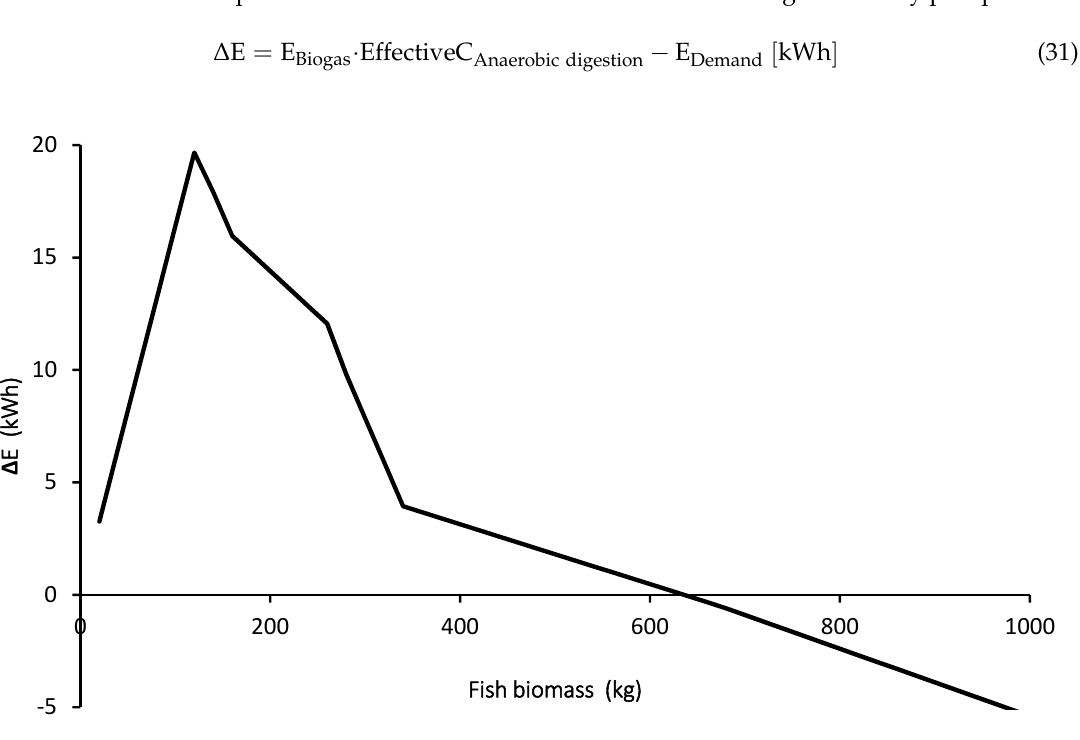
Figure 5. The effect of fish biomass on the differences between the aquaponic system energy demand and production ( ∆ E). Negative ( ∆ E) represents energy gain.